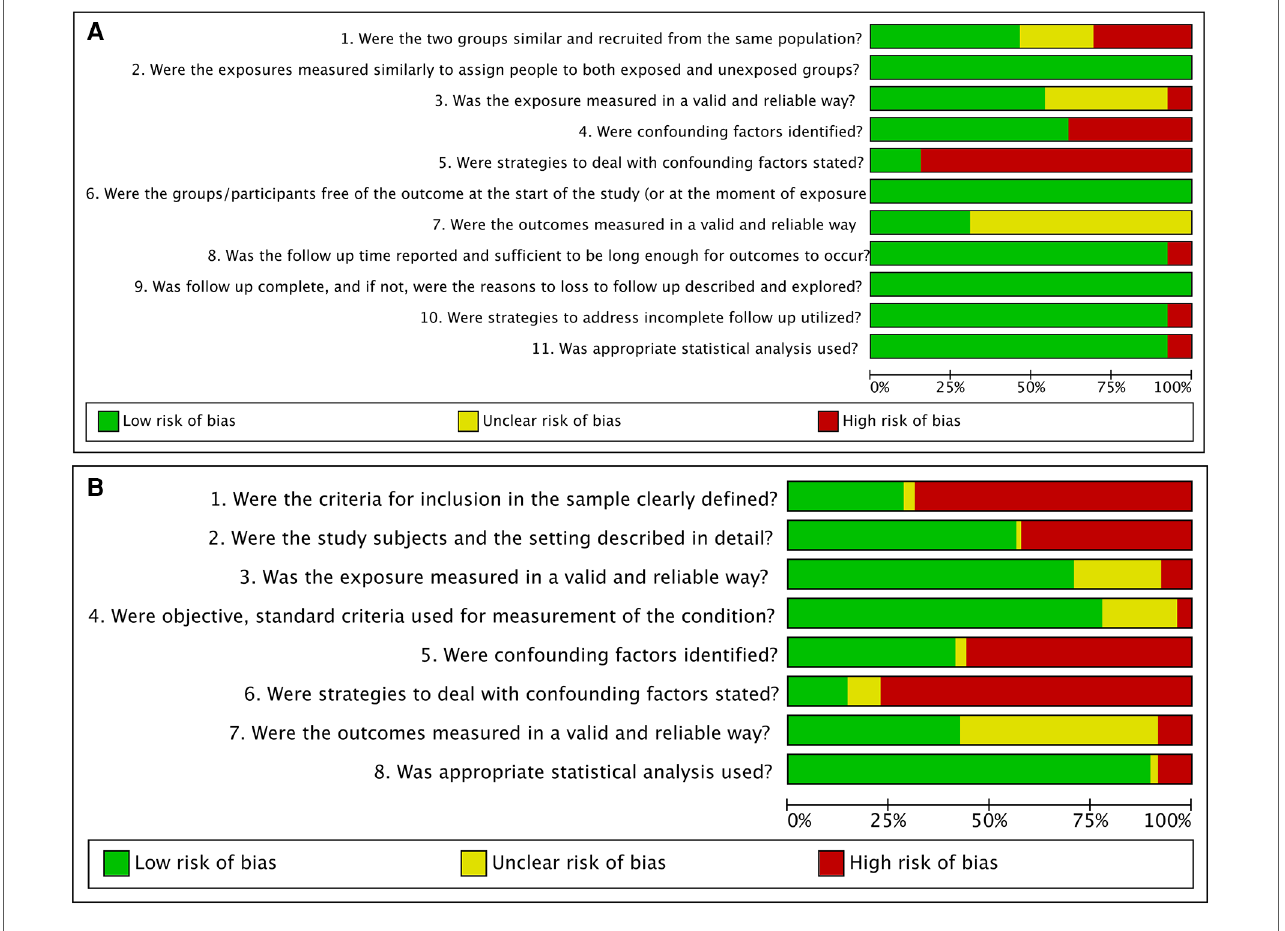
FIGURE 2 Risk of bias summary: review authors ’ judgements about each risk of bias item presented as percentages across cohorts ( A ) and cross-sectional studies ( B